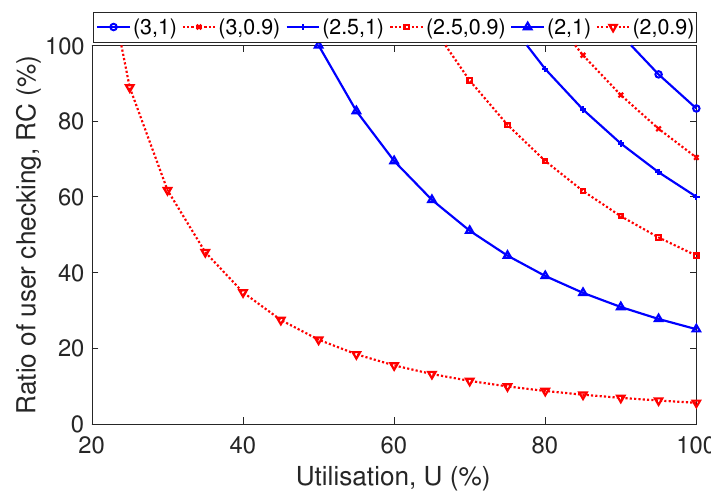
Figure 3. Contact tracing application utilization thresholds for controlling an infection, considering different values of reproduction ratio ( R 0 ) and percentage of susceptible people ( S / N ). The pair of values above the lines results in a disease-free equilibrium.